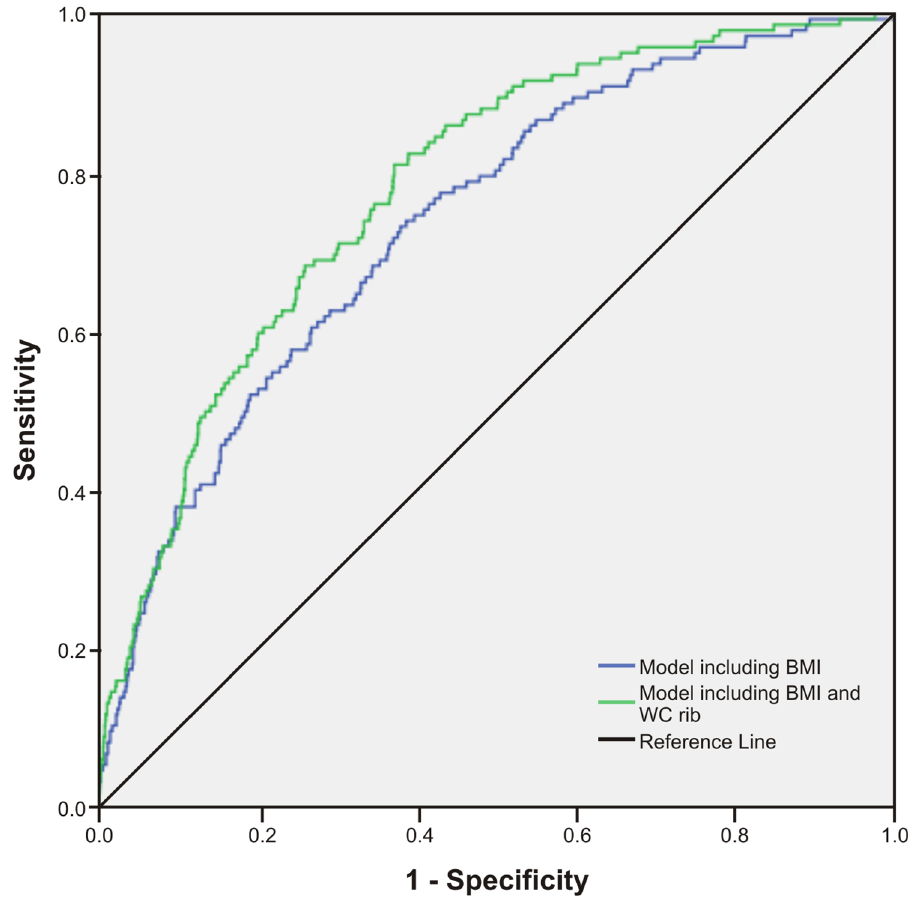
Fig 7. Receiver operating characteristic curves for prediction models to discriminate subjects with type 2 diabetes. Figures show ROC curves for a model including BMI and a model including BMI and WC rib. All models include age and